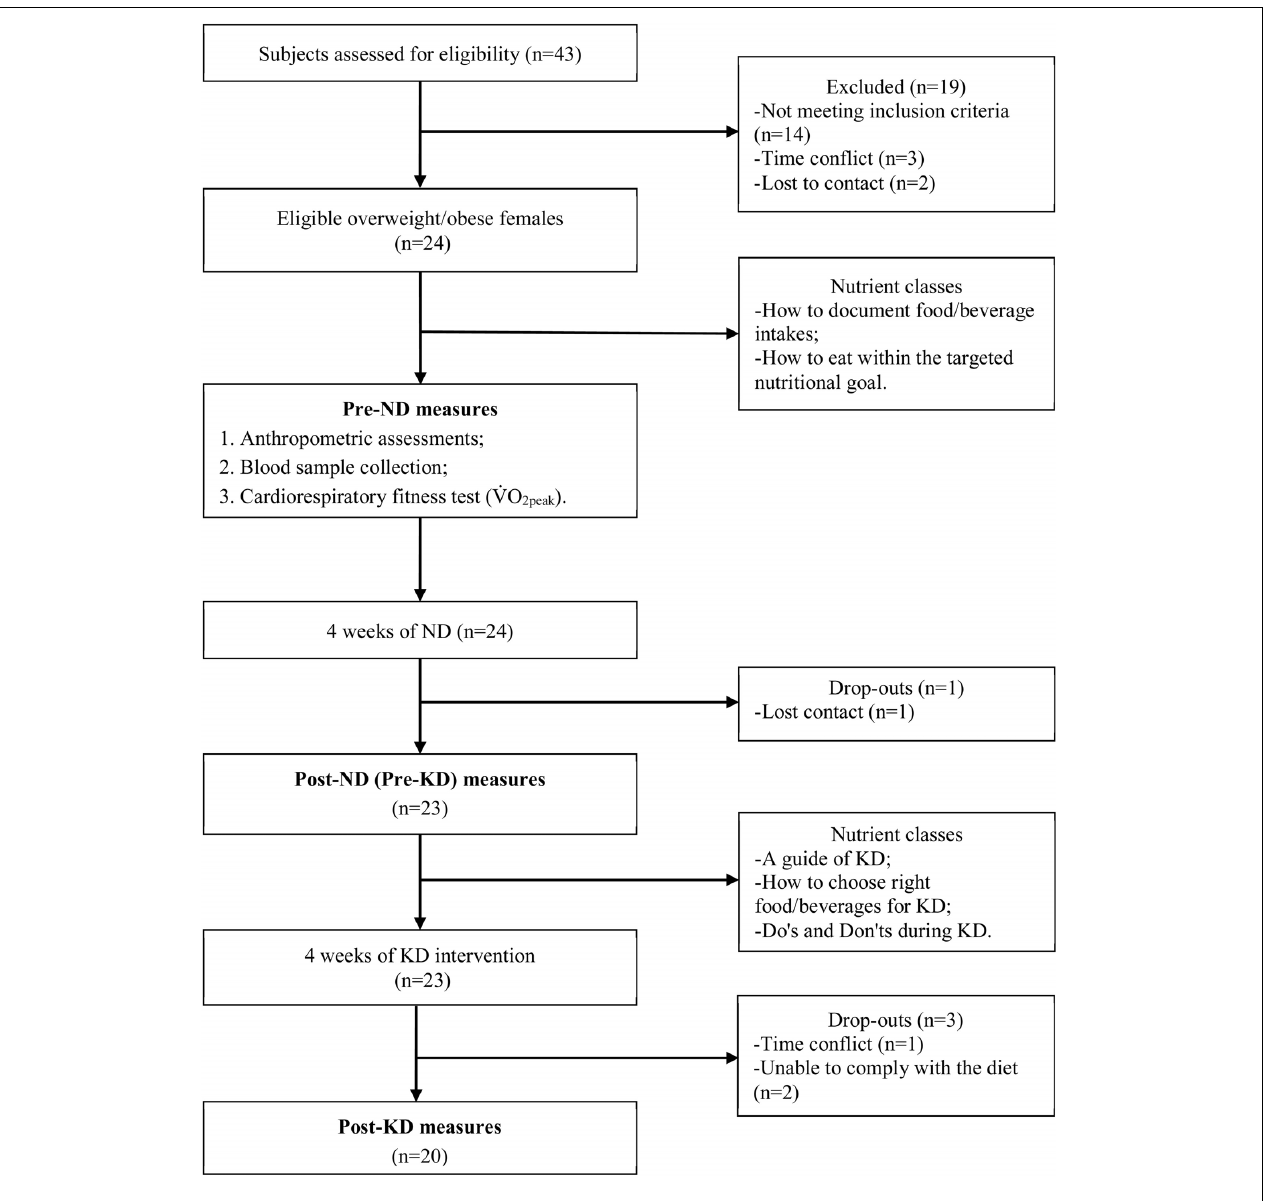
FIGURE 1 | Flow-chart of the